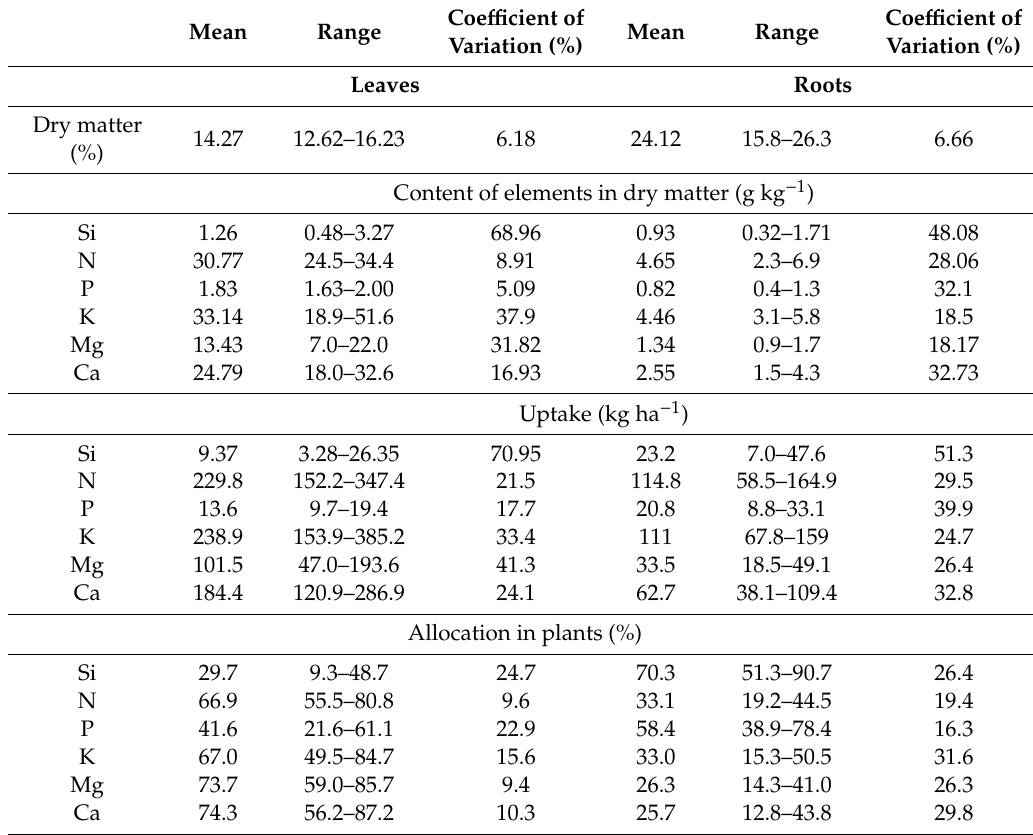
Table 4. Variability parameters of the nutrient content and uptake in sugar beet leaves and roots in 2013 and 2014.